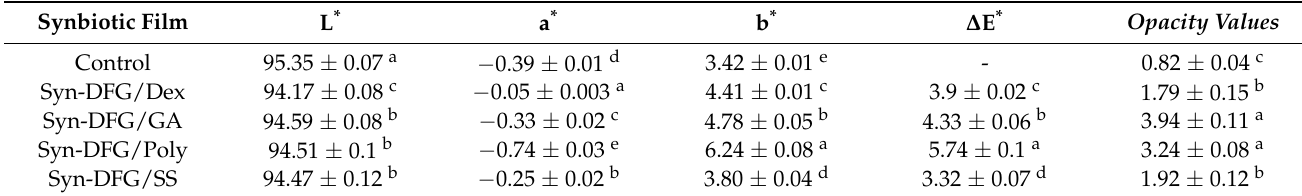
Table 2. Optical and color properties of edible synbiotic films containing L. casei and different types of prebiotic fibers. Synbiotic